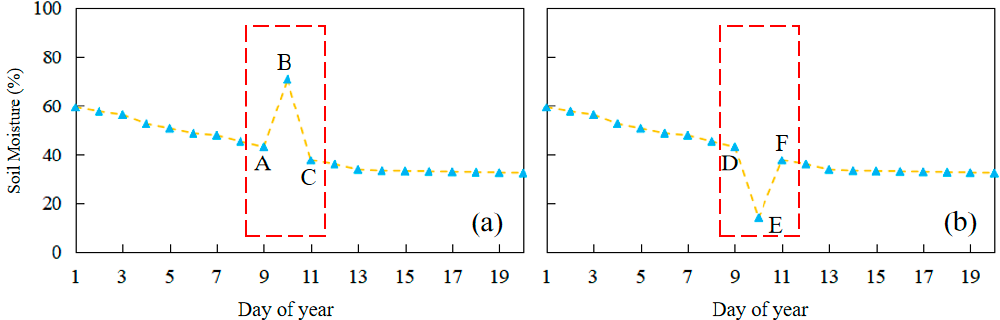
Figure 5. Schematic of abnormal soil moisture in the soil moisture decreased stage. ( a ) soil moisture at time A less than at time B, but that at time B greater than at times C. ( b ) soil moisture at time D less than at time F but that at time D greater than at times